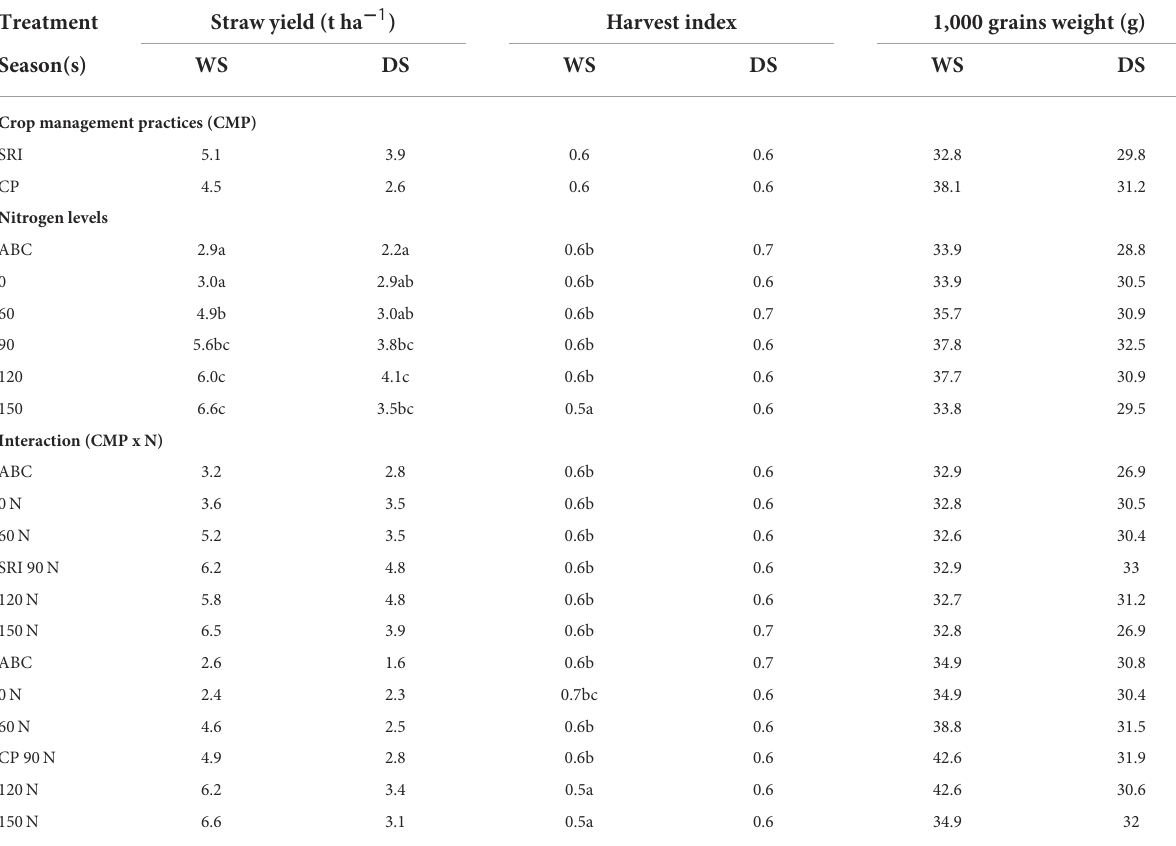
TABLE 13 Effects of crop management practices and N levels on straw yield, harvest index, grain yield and 1,000 grains weight of rice.